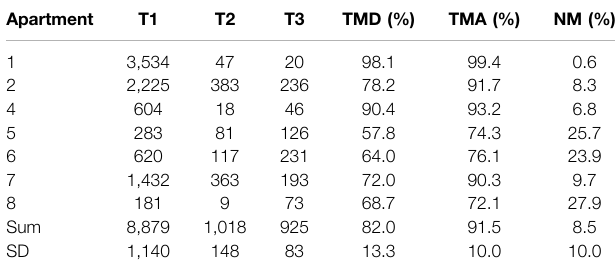
TABLE 5 | TMD, TMA, and NM results for carpenter one in apartment seven. Metrics Calculation Results